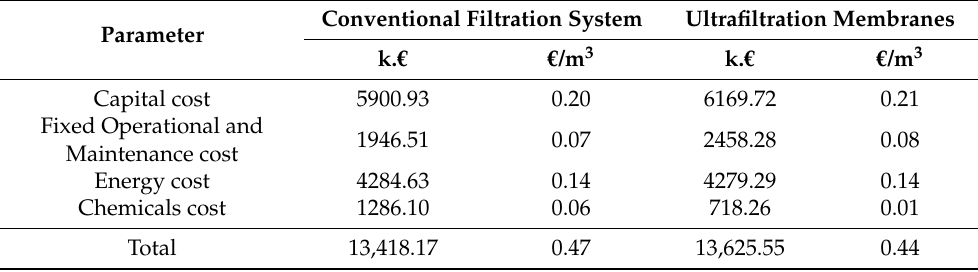
Table 3. Comparative costs for a water membrane filtration unit and a conventional granular filtration